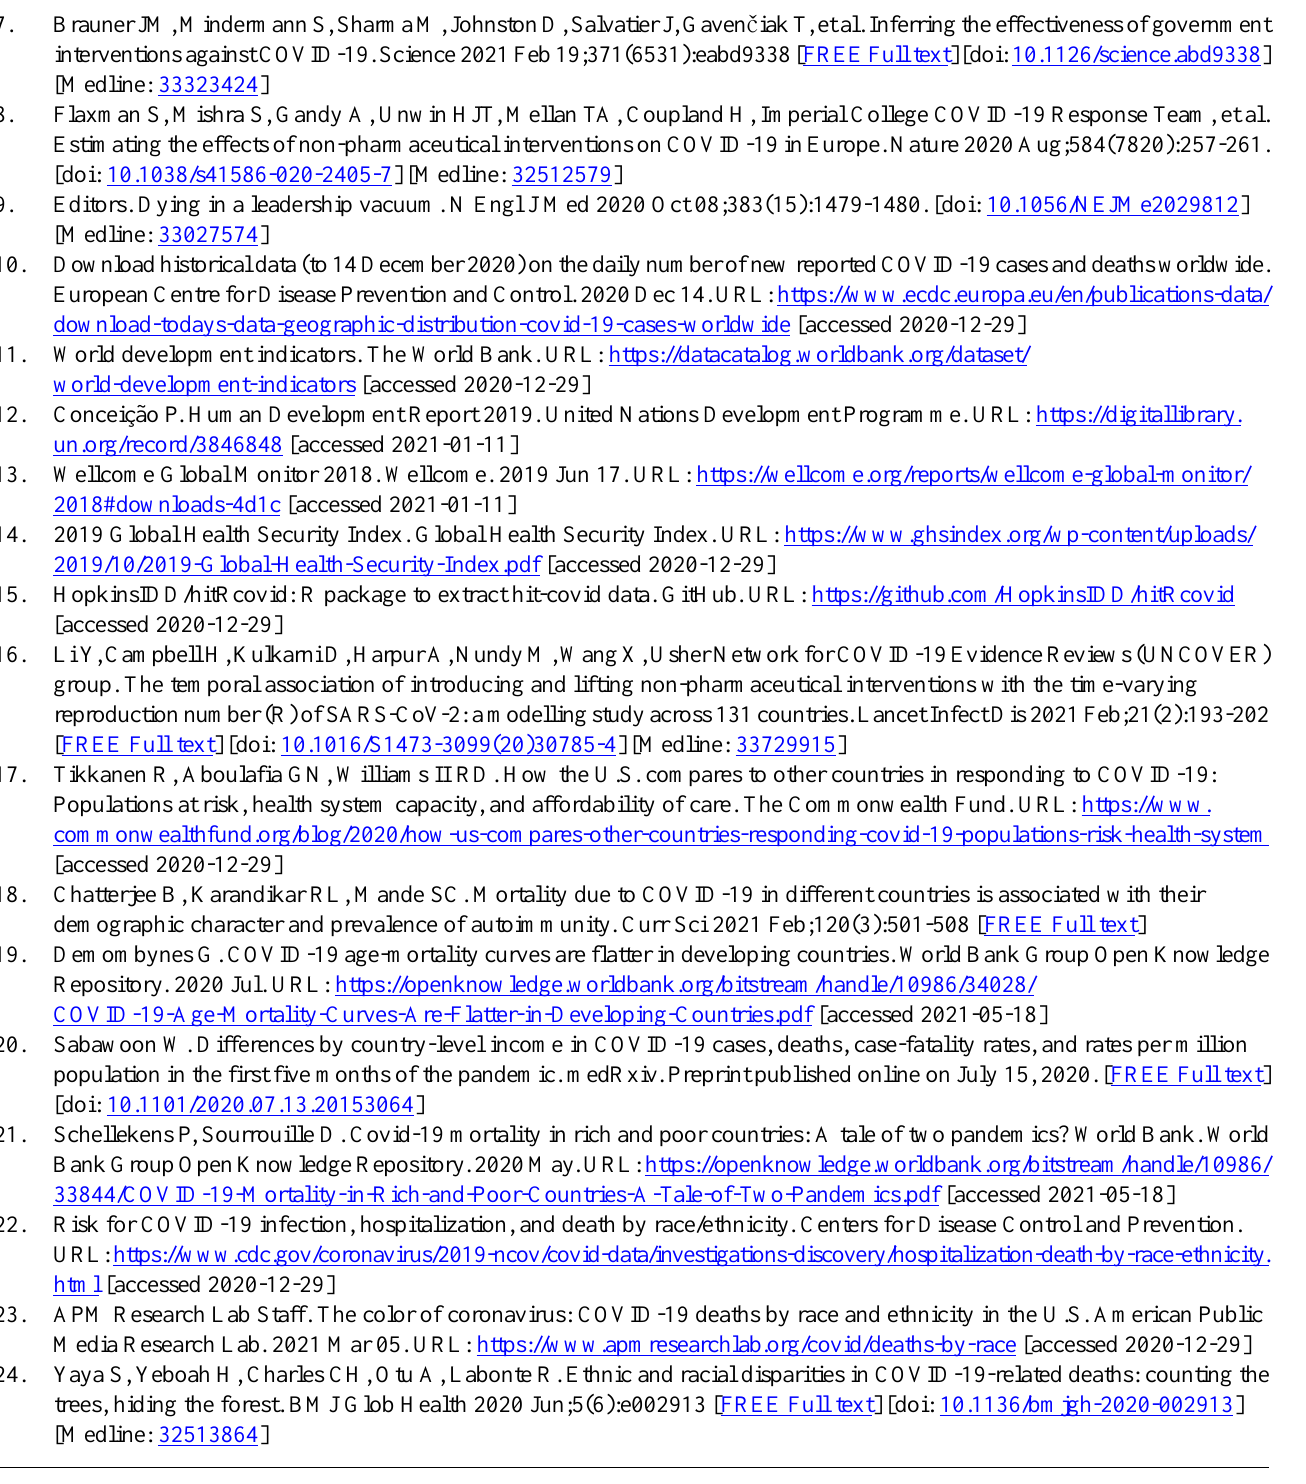
HIT-COVID: Health Intervention Tracking for COVID-19 LMIC: low- and middle-income countries PHSM: public health and social